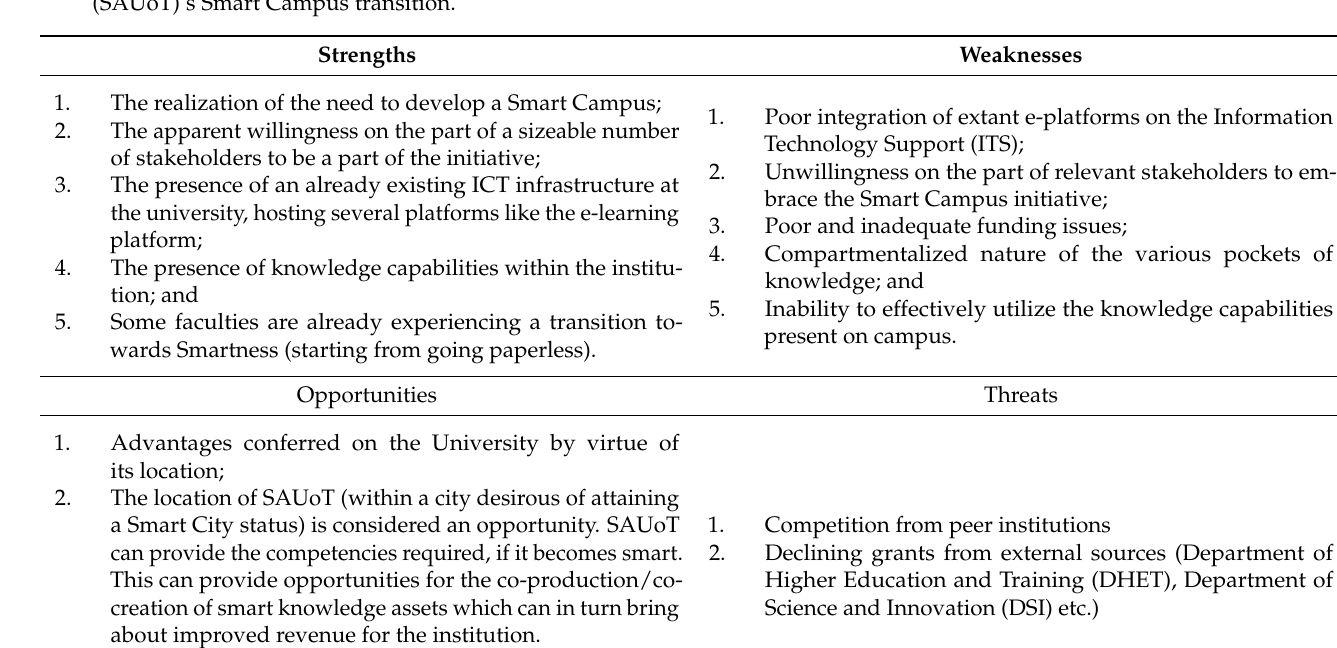
Table 3. A strengths, weakness, opportunities, and threats (SWOT) analysis of the South Africa University of Technology (SAUoT)’s Smart Campus